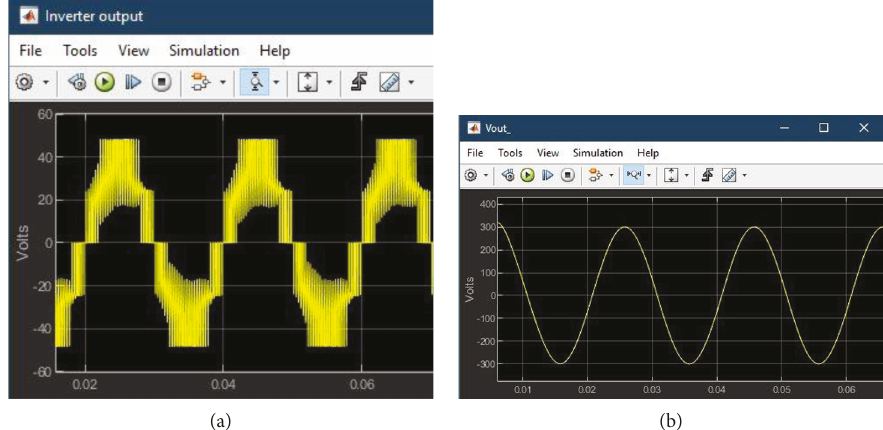
Figure 8: (a) Output of the 6-step inverter (low-voltage side). (b) Final output of 50Hz, 212V RMS for the AC load (high-voltage